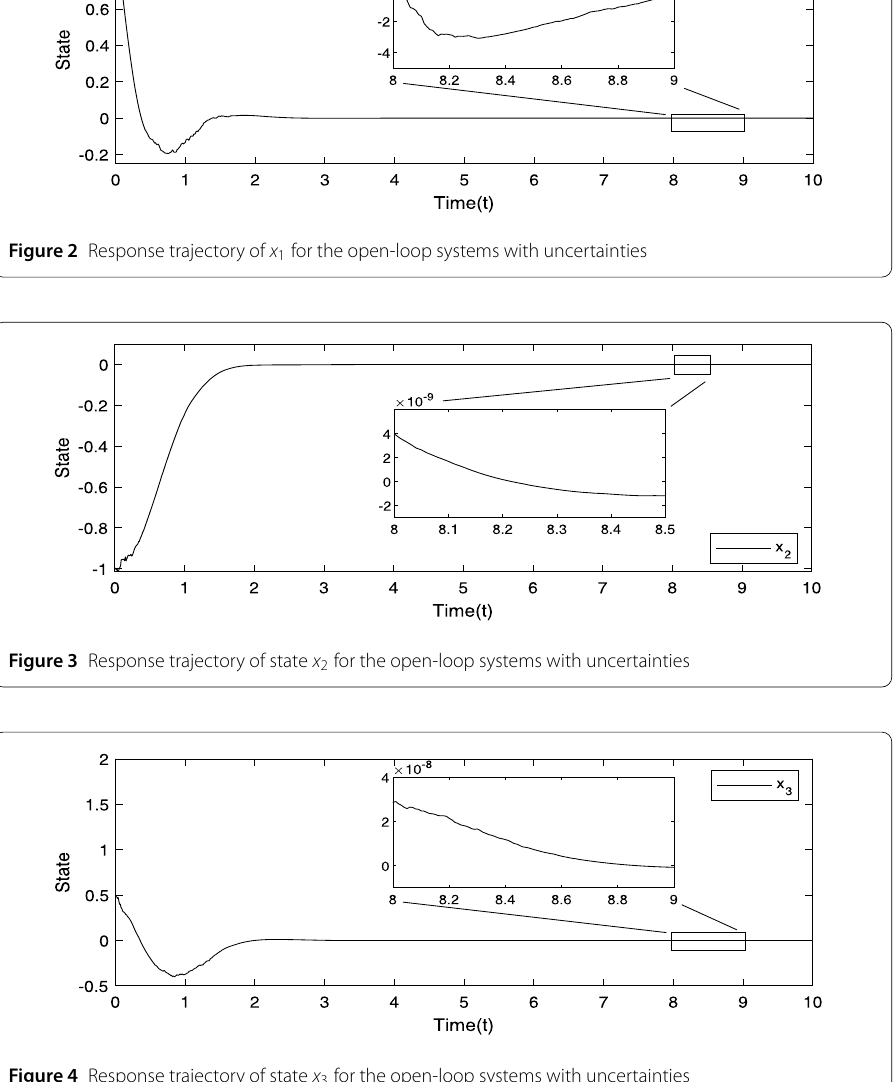
Figure 4 Response trajectory of state x 3 for the open-loop systems with